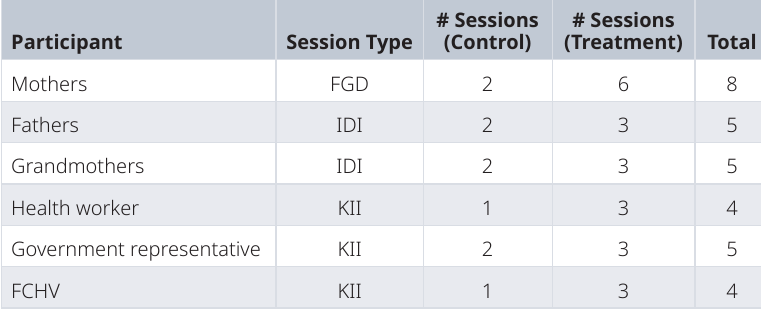
Table 1. Breakdown of qualitative data collection by treatment and control